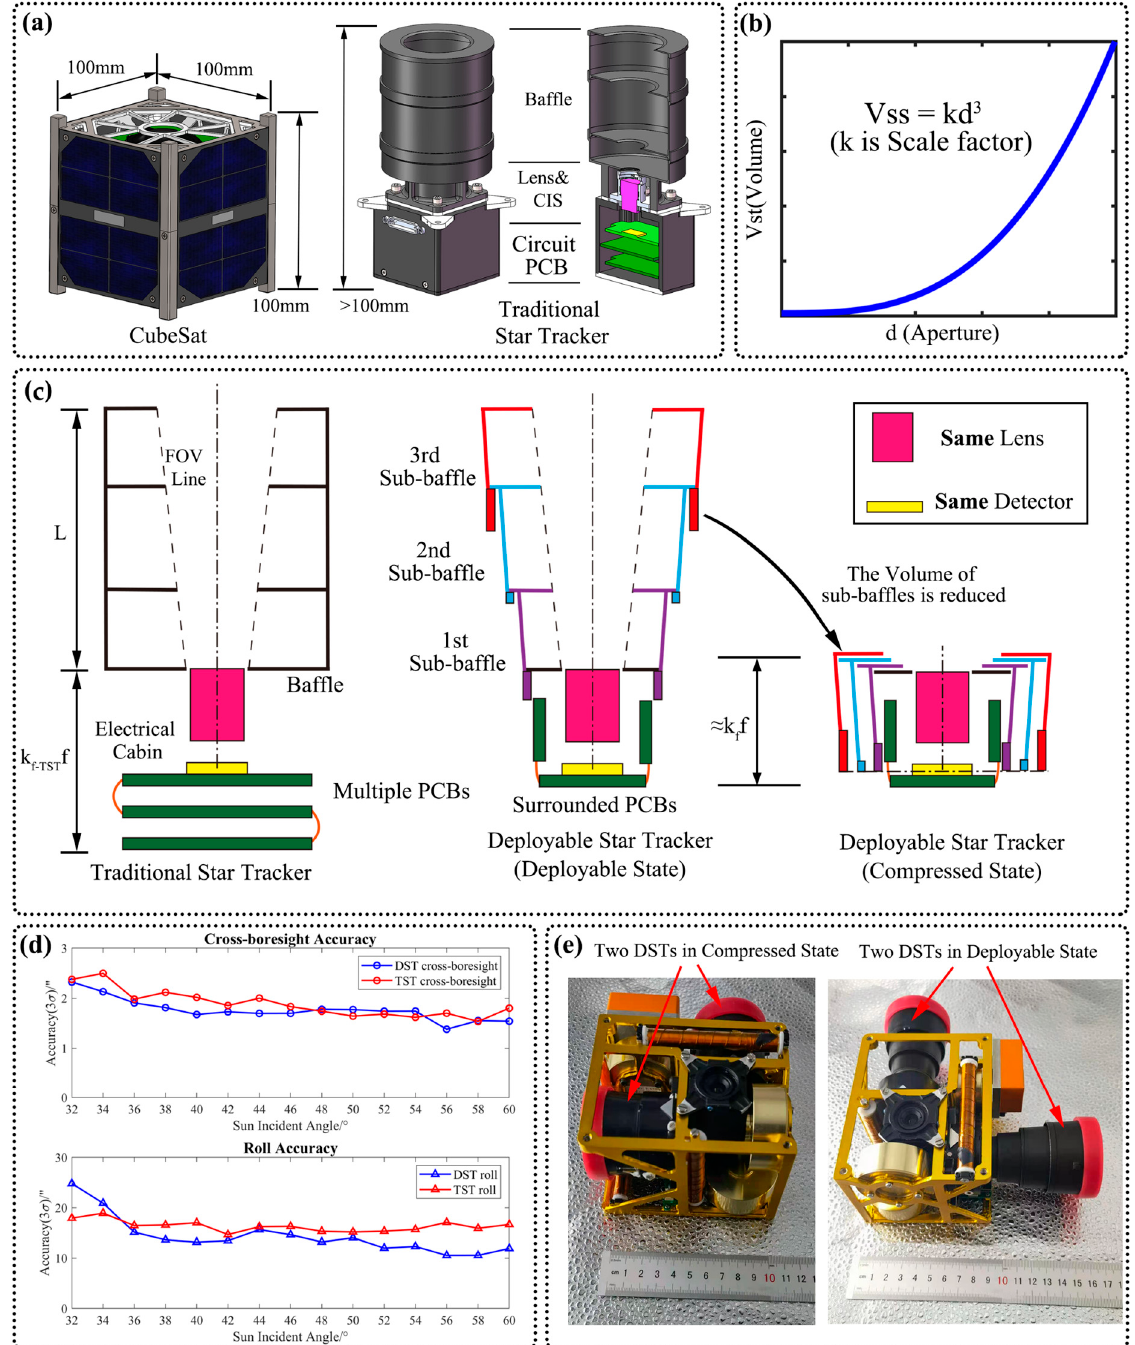
Figure 1. ( a ) The comparison between the CubeSat(1U) with TST and the structure of TST. ( b ) The relationship between the volume and the aperture of the star tracker. ( c ) The proposed DST with deployable state and compressed state. ( d ) The accuracy between DST and TST under different sun incident angles. ( e ) The practical product of IADCS for CubeSats and DST in compressed state and deployable state,